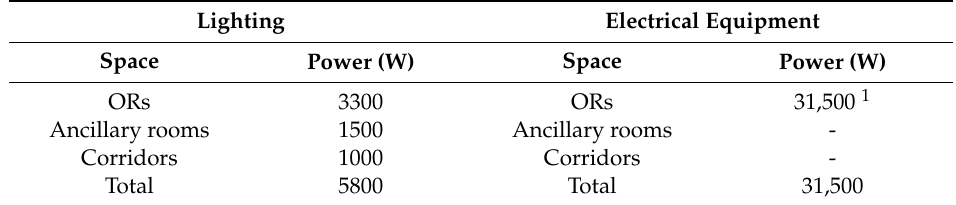
Table 1. Lighting and electrical equipment power in the surgical